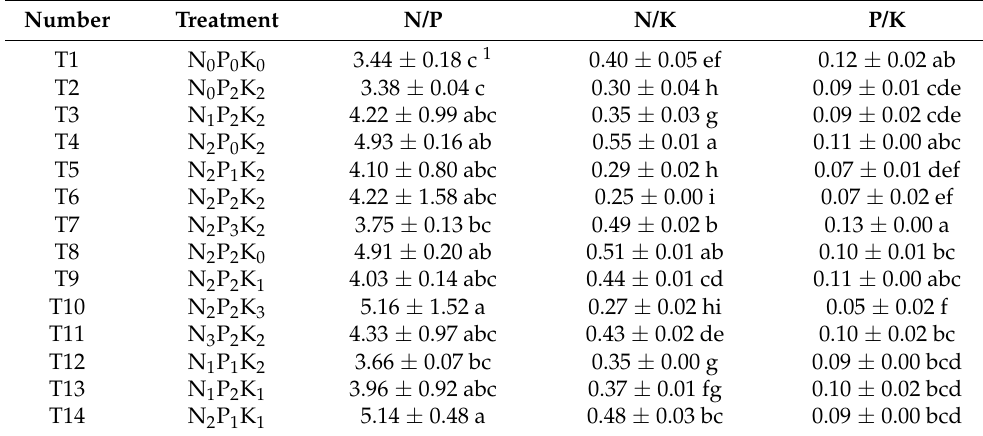
Table 8. N, P, K element absorption balance of P. bournei seedlings under different N-P-K fertilization.